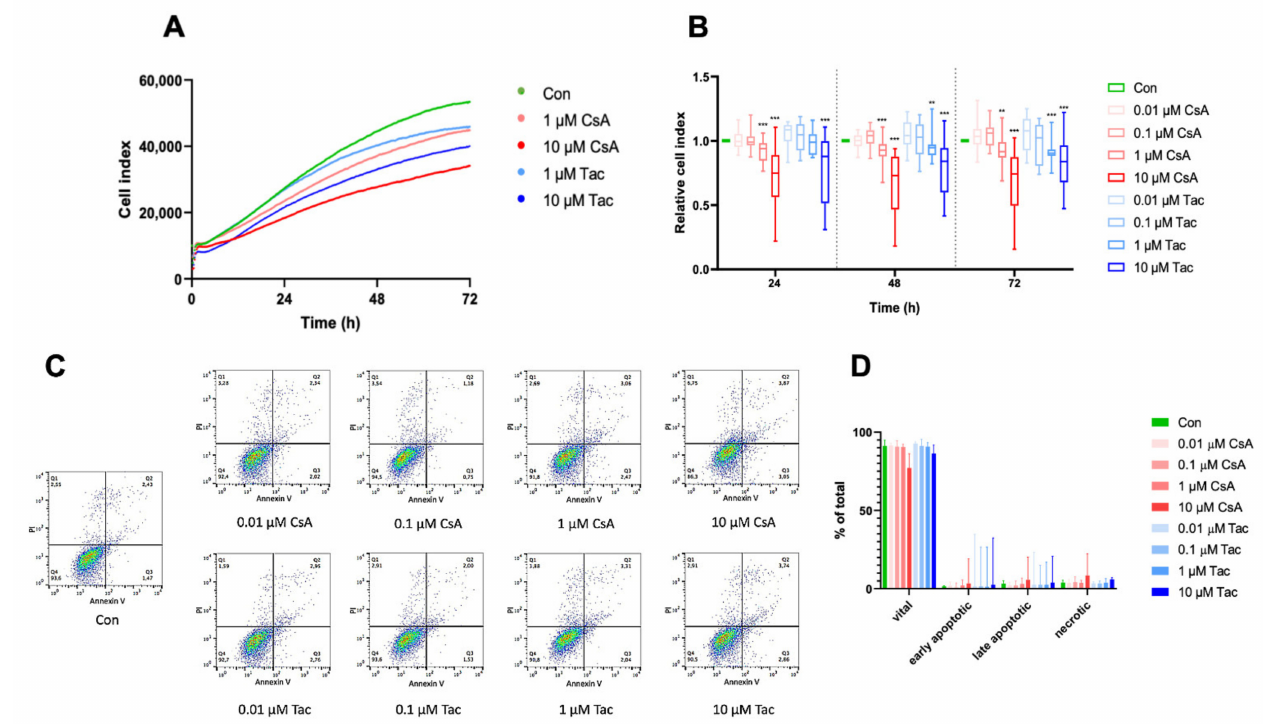
Figure 1. High-dose cyclosporine A (CsA) and tacrolimus (Tac) impaired ECFC proliferation. ( A ) Overlay of growth curves of ECFCs treated with CsA or Tac (1 µ M or 10 µ M). ( B ) ECFC proliferation was not affected after treatment with 0.01 or 0.1 µ M CsA or Tac, but it was significantly decreased after treatment with 1 µ M or 10 µ M CsA or Tac after 24 h, 48 h, and 72 h. n = 13–27; control group set as 1. ( C ) Representative measurement of apoptosis and necrosis in ECFCs after 48 h treatment with CsA or Tac at 0.01 µ M, 0.1 µ M, 1 µ M, or 10 µ M. Viable cells are located in the lower left field (Annexin V neg./PI neg). ( D ) There was no significant increase of apoptotic or necrotic cells. n = 5. Con—control; CsA—cyclosporine A; Tac—tacrolimus. ** p < 0.01, *** p <